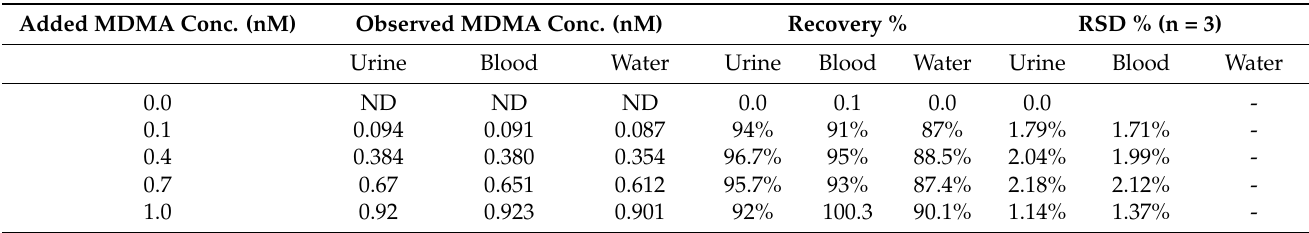
Table 4. Evaluation of Apt MDMA /SnNPs@Au-based sensing system for MDMA detection in spiked urine, blood, and water